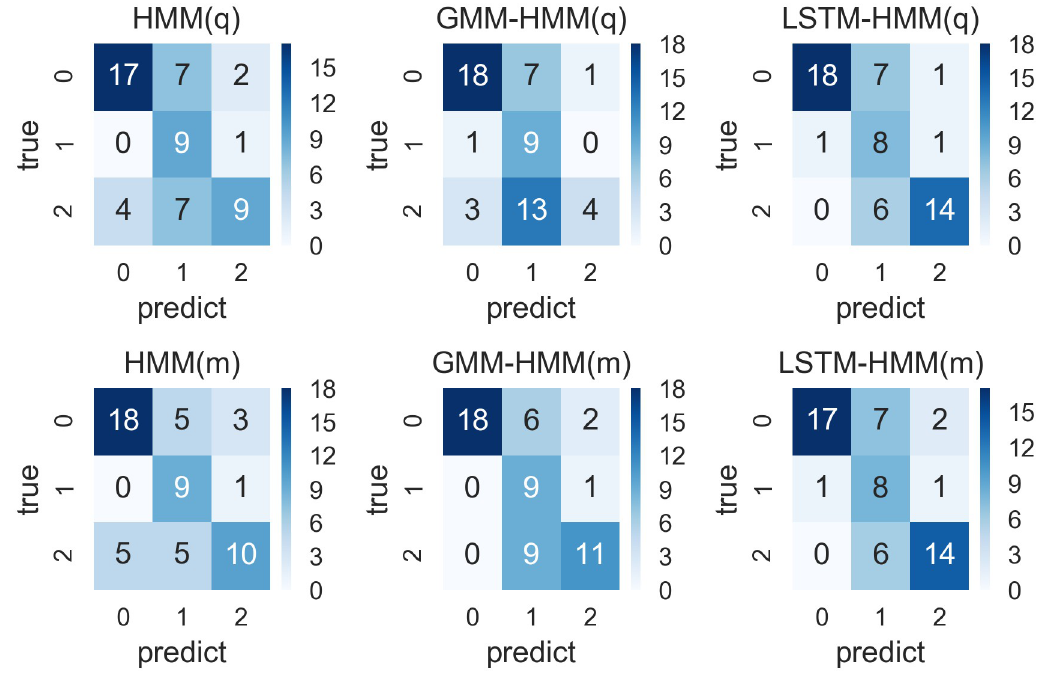
Fig 9. Confusion matrixes for prediction results from HMM, GMM-HMM and LSTM-HMM with monthly or quarterly input and 6-year time window.